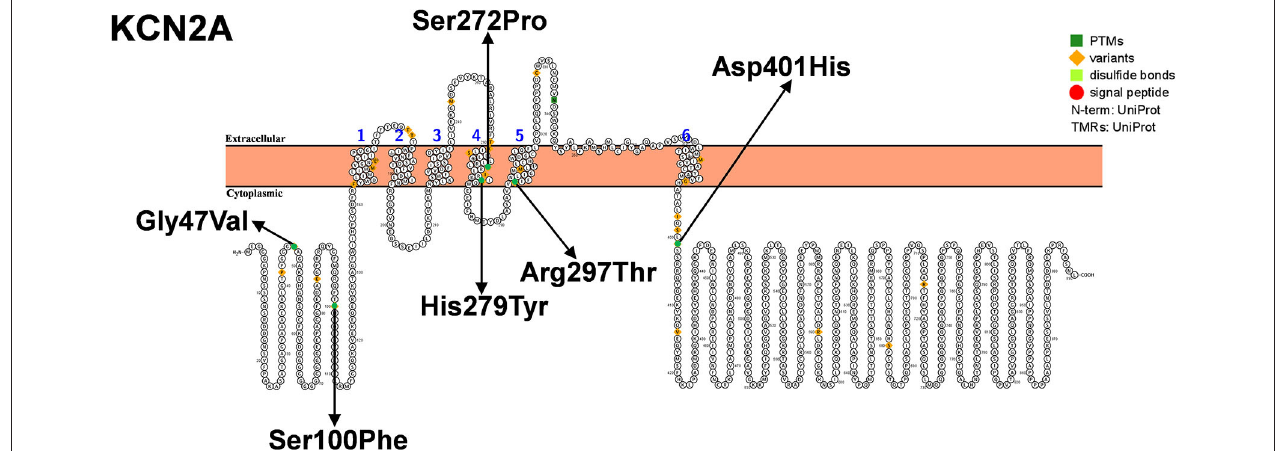
FIGURE 5 | Schematic diagram of protein encoded by KCN2A , illustrating the location of the amino acids affected by the mutations identified in patients.